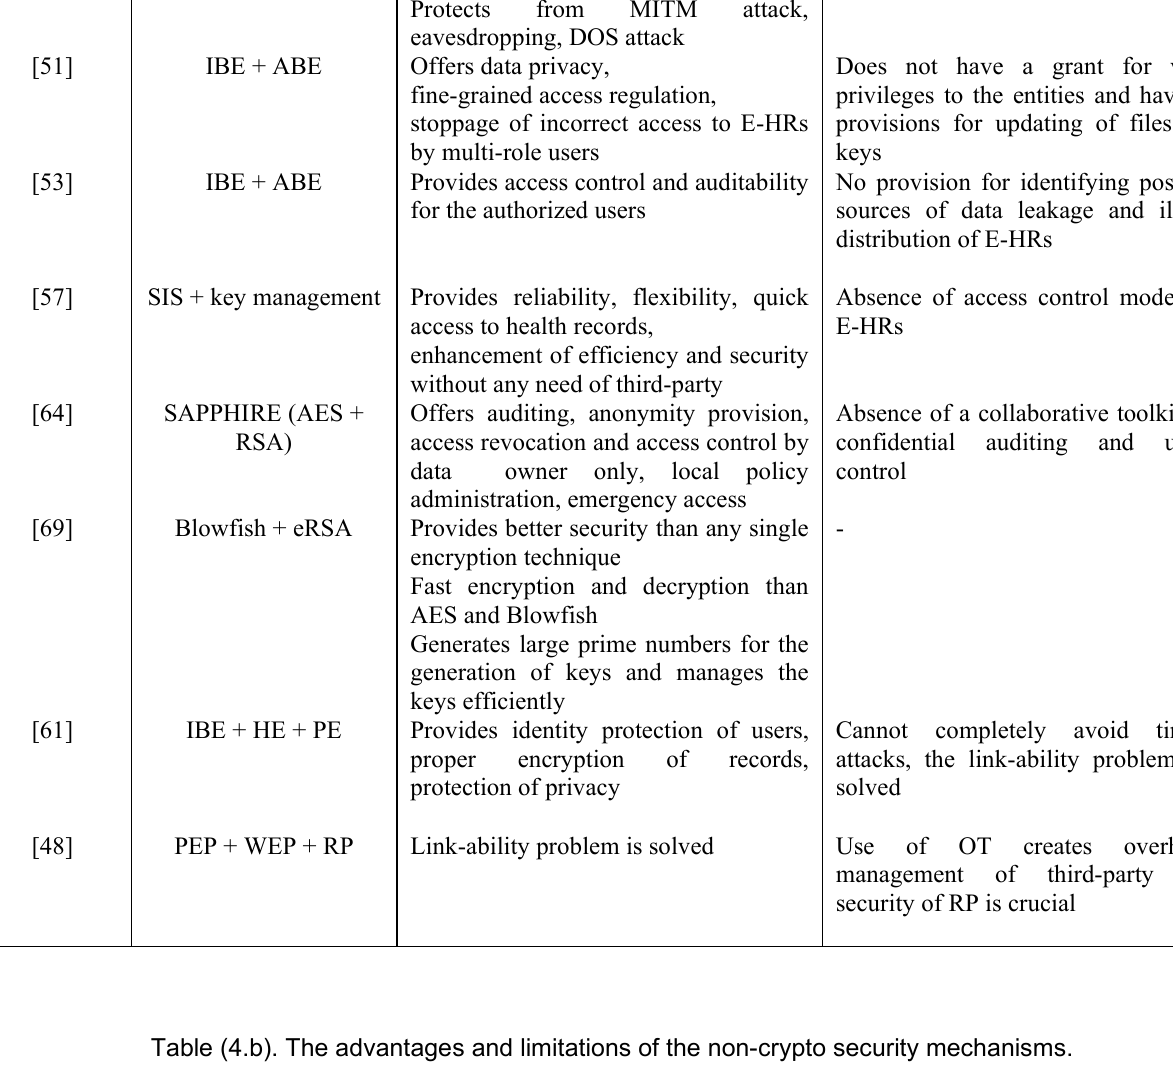
Table (4.b). The advantages and limitations of the non-crypto security